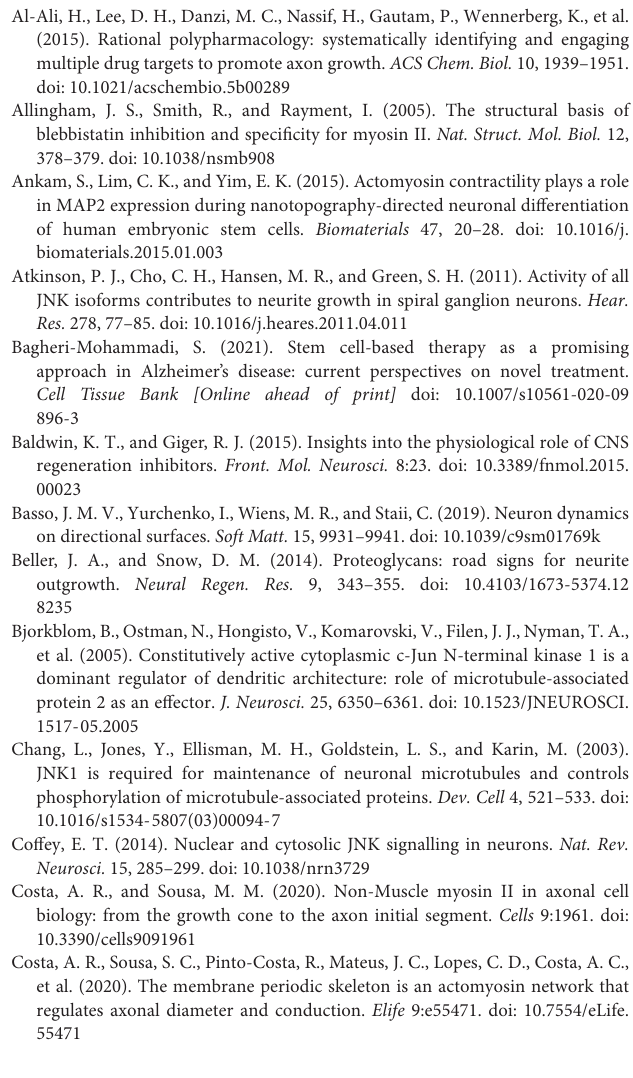
iPSC-derived NPCs was performed with NPCs differentiated from the human embryonic stem cell line, HUES9. The NPCs were subjected to para-nitroblebbistatin in the indicated concentrations, and the total lengths of neurites were determined in six fields of view. The neurite lengths were normalized to the initial values. Initial neurite outgrowth rates were calculated from experiments similar to that depicted here, and a dose-response curve was generated (see Figure 2F ). Supplementary Figure 4 | Cell morphology of NPCs grown on different extracellular matrices. eGFP-expressing NPCs were seeded onto various extracellular matrices as indicated (pOrn, poly-ornithine; pLys, poly-lysine). Images were acquired before and 4 h after the addition of para-nitroblebbistatin (10 µ M). Scale bars indicate 10 µ m. Supplementary Videos 1, 2 | Time-lapse images of NPCs in the presence and absence of NBS. NPCs expressing eGFP were subjected to DMSO (vehicle control, Supplementary Video 1 ) or 10 µ M para-nitroblebbistatin ( Supplementary Video 2 ), and the morphological changes were monitored for 4 h in 15 min